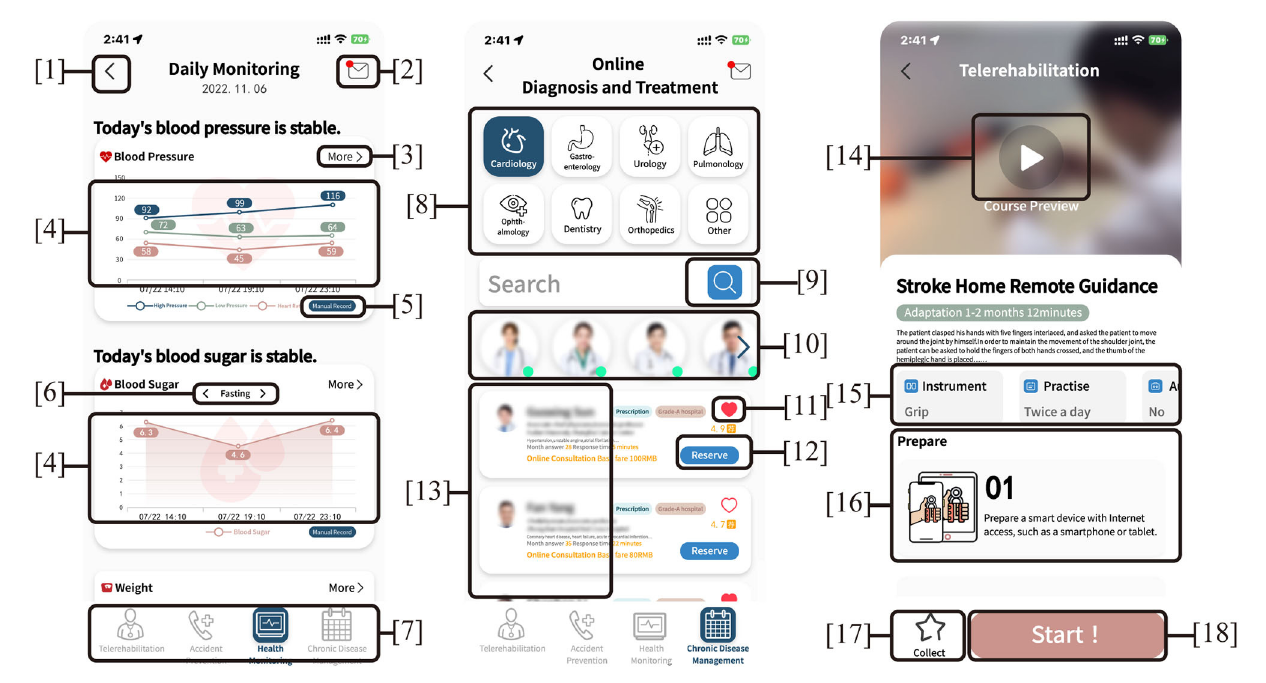
FIGURE3 Design patterns of Interface: (1–3, 5, 6, 9, 11, 12, 14, 17, 18) assisted navigation buttons, (4) management interface, (7) tab menu, (8) springboard, (10) gallery, (13) lists, (15,16)